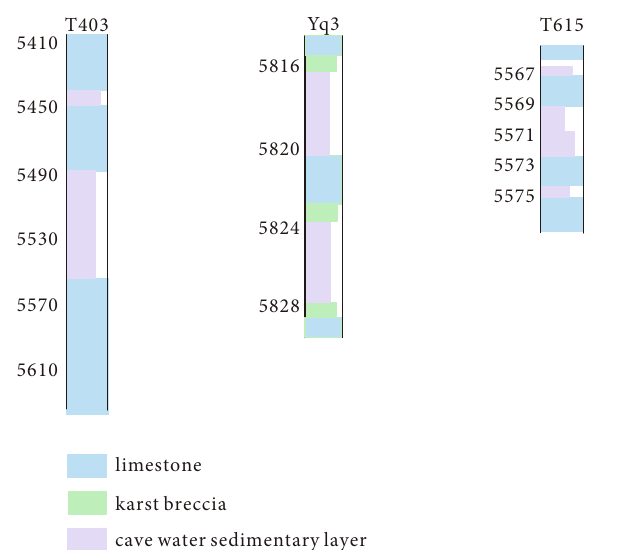
Figure 9: Karst fi lling in well section 4929.00-4980.78m of yq3 well in Yuqi Area of Tahe Oil fi